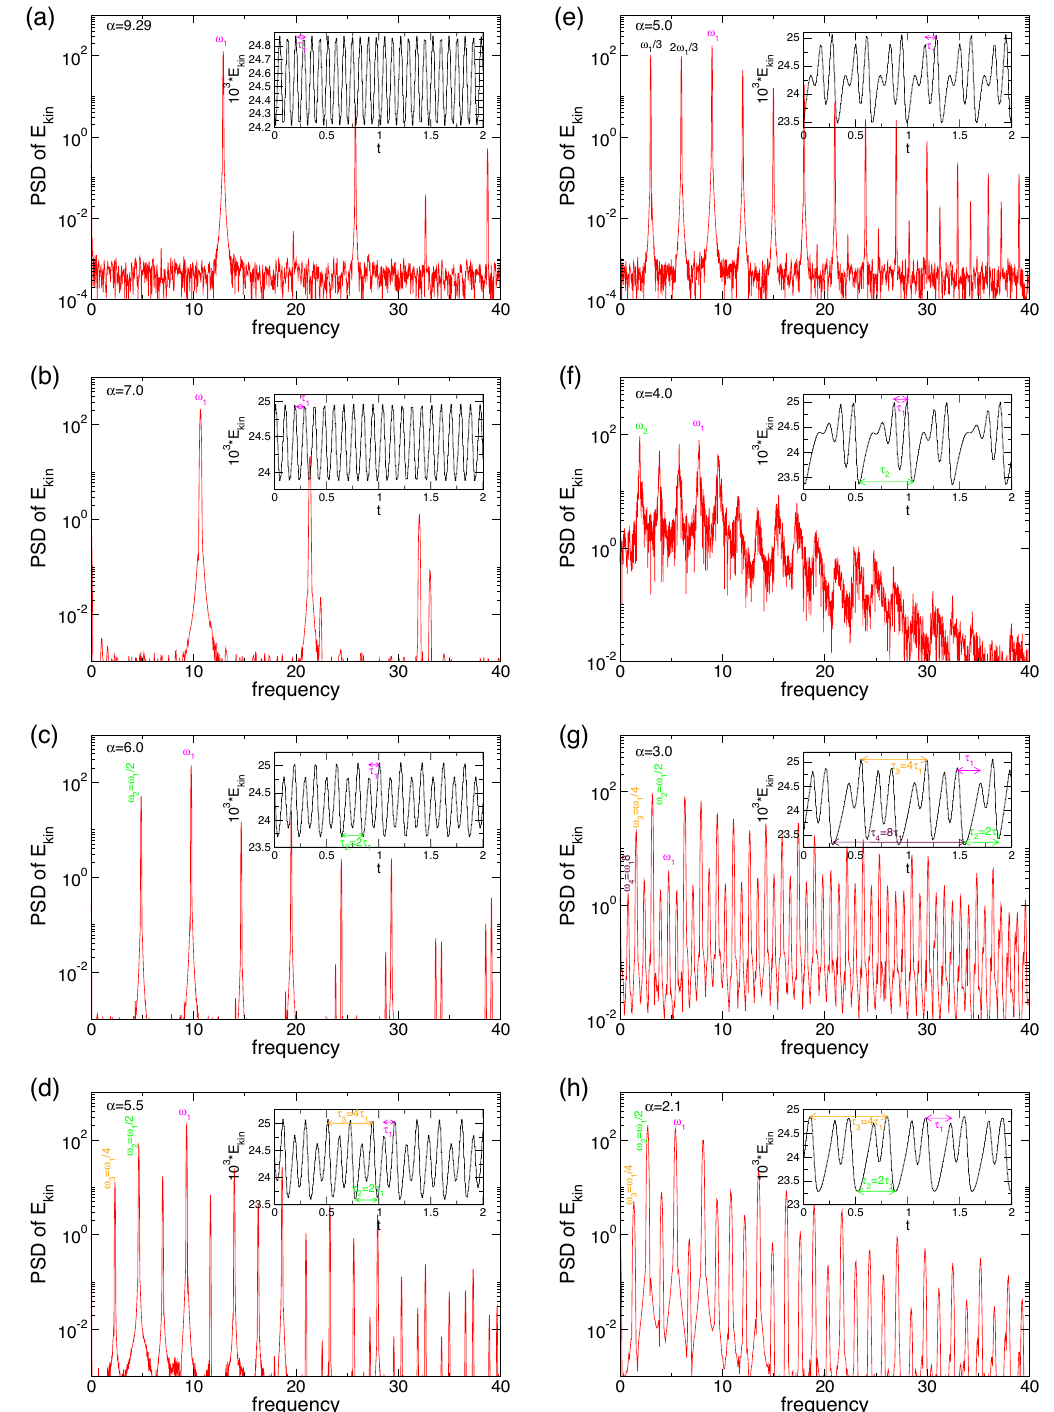
Figure 19. Time series and power spectral densities (PSDs) of E kin of unstably propagating flow states, pV u , for different α , as indicated. Insets show time series of E kin . In both, dominant times and frequencies, respectively, are highlighted. Note that all PSDy belong to limit cycle solutions (see Fig. 17) but ( f ) presents a 2-torus their more complex cousins, MRWs, appear stable over a wide range of α , and both RW and MRW are non- 0 mode. axisymmetric in the m = In addition to previously known pVs, we observed new axisymmetric and time-dependent solutions with variations in α . These were either pure pulsating flow structures (T2 puls ) or propagating vortices (pVs), the latter with and without pulsation . The pulsating flow structure, T2 puls , appears via a supercritical Hopf bifurca- 0 mode), and T2 is tion out of a stationary twin-pair flow, T2. As N2 and T2 states are axisymmetric (pure m =